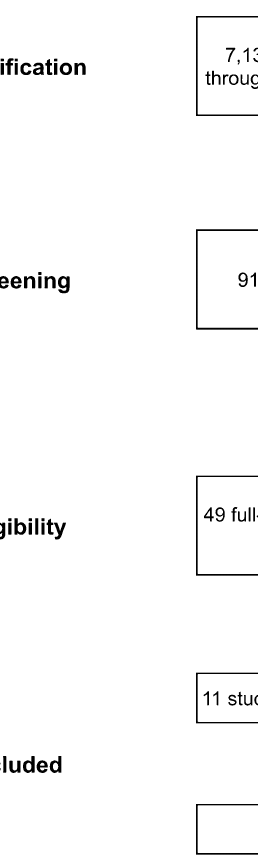
Figure 1. Flow-chart of the selection process for the studies included in the literature review and meta-analysis on the association between use of exogenous sex hormones, menstrual and reproductive history, and risk of non-melanoma skin cancer among